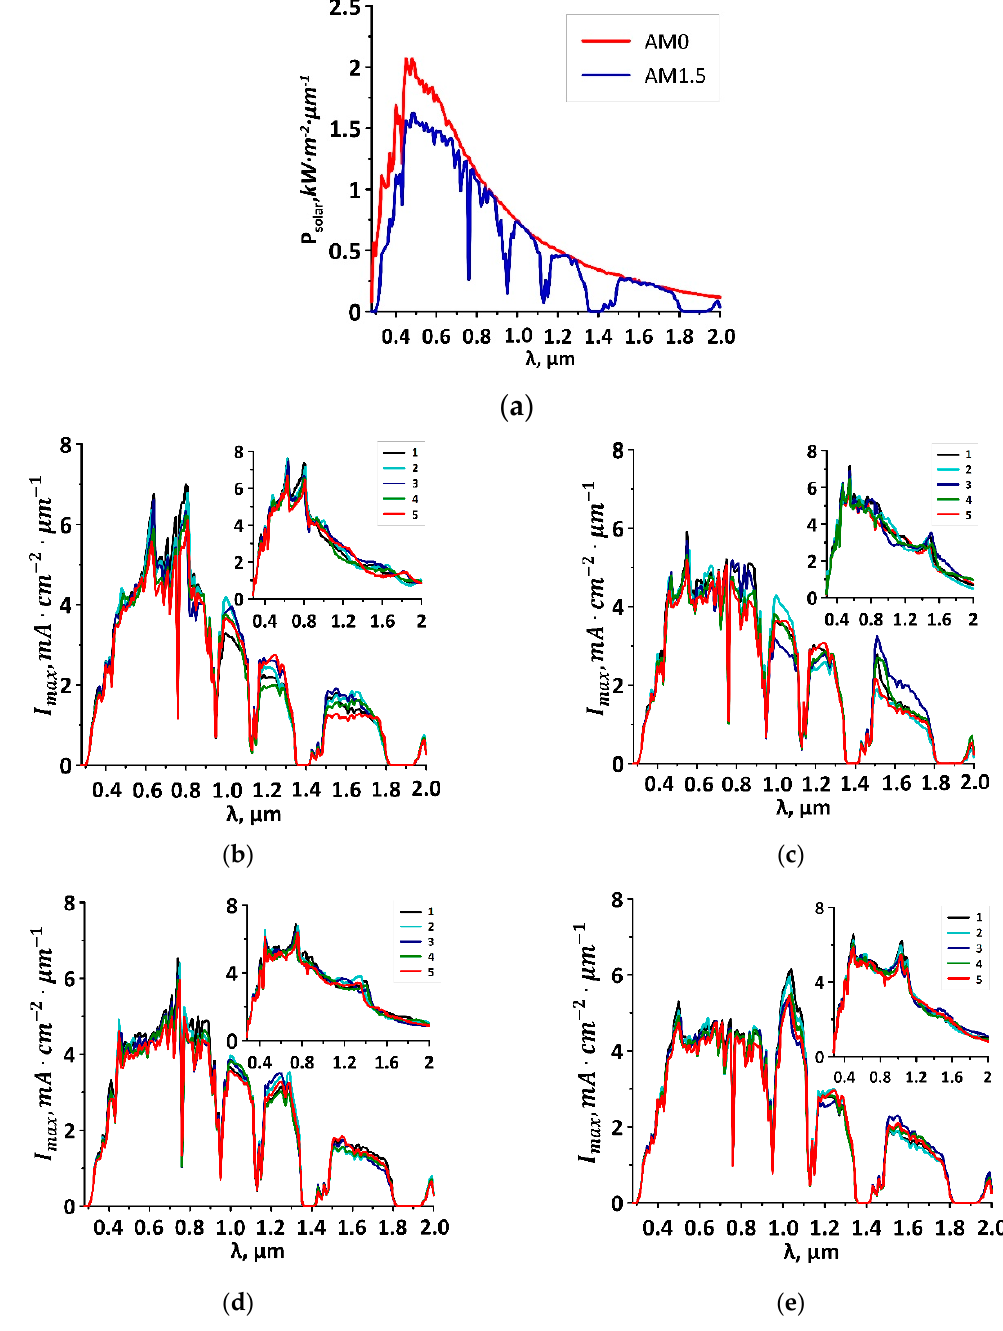
Figure 5. Photocurrent of graphene/SWCNT composite films for the solar spectrum at AM1.5, and in the inserts at AM0: ( a ) solar power spectrum; ( b ) films with SWCNTs (10,0), numbers 1–5 correspond to H1/H2 of 6/7–6/11 hexagons; ( c ) films with SWCNTs (12,0), numbers 1–5 correspond to H1/H2 of 7/8–7/12 hexagons; ( d ) films with SWCNTs (14,0), numbers 1–5 correspond to H1/H2 of 8/9–8/13 hexagons; ( e ) films with SWCNTs (16,0), numbers 1–5 correspond to H1/H2 of 9/10–9/14 hexagons.